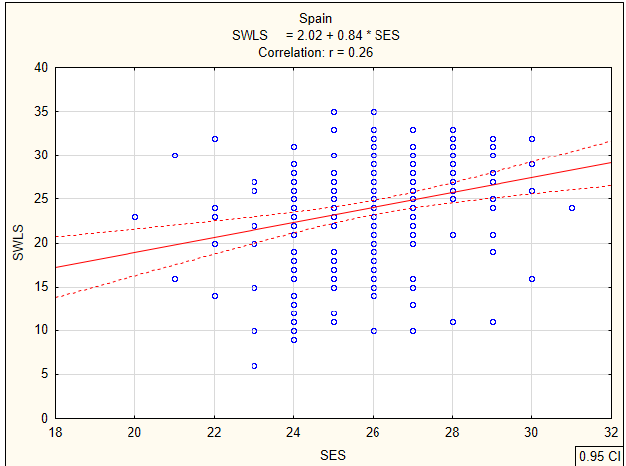
Figure 7. Correlation between global self-esteem according to SES and life satisfaction according to SWLS among Spanish students.